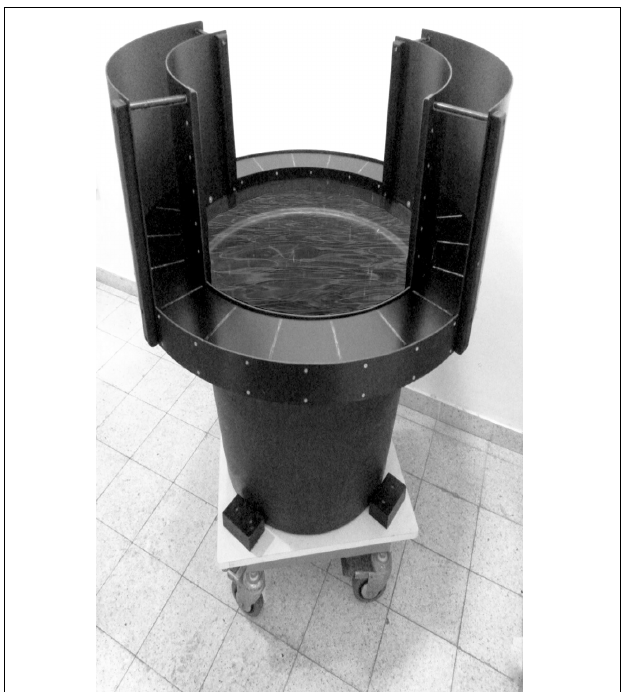
FIGURE 1 | The water associated zero maze. An annular platform (90cm diameter; 10cm width), made out of black plywood, joined to a plastic tank (70cm diameter, 55cm deep) elevating it 55cm above the ground. The annular platform has two opposite, enclosed quadrants (with walls 35cm height) and two open quadrants (with borders 5mm height). The plastic tank that holds this platform is filled up with water (22 ± 2 ◦ C, 50cm